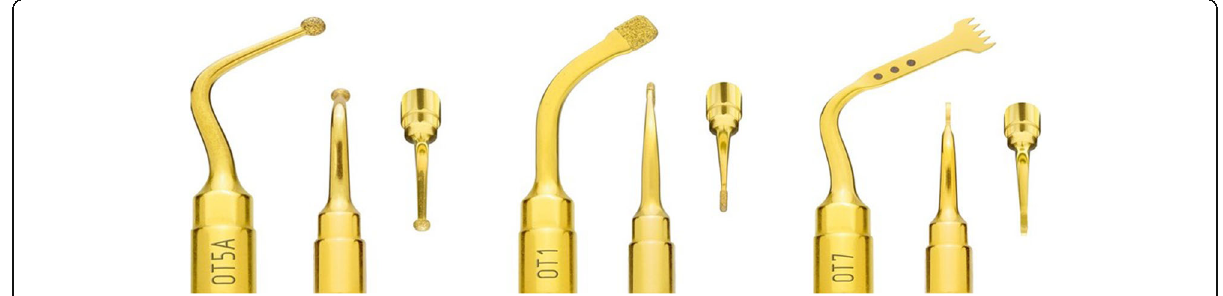
Fig. 1 The piezosurgery tips used in this study are OT1, OT7, and